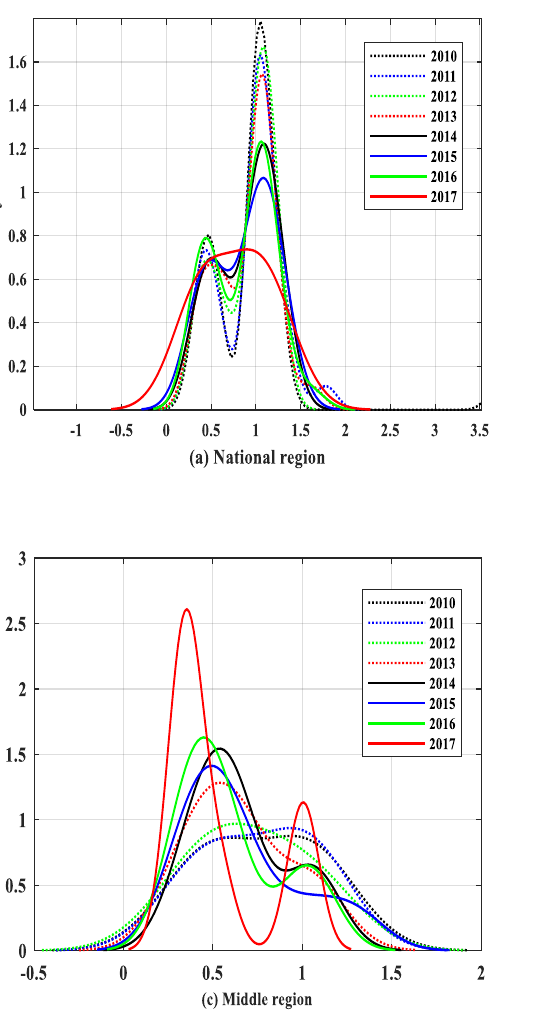
Figure 4. Kernel density curve of the ( a ) national region; ( b ) eastern region; ( c ) middle region; ( d ) western region (China).